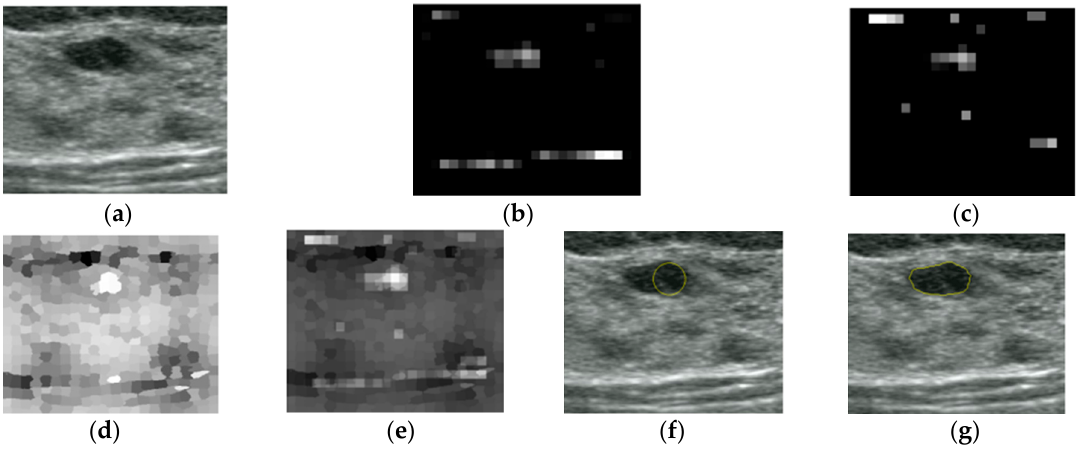
Figure 13. The localization and segmentation procedures of a US breast image. ( a ) Original image, ( b ) intensity saliency map, ( c ) blackness ratio saliency map, ( d ) superpixel saliency map, ( e ) combined saliency map of three features, ( f ) localization results, and ( g ) segmentation results by the CV level set.